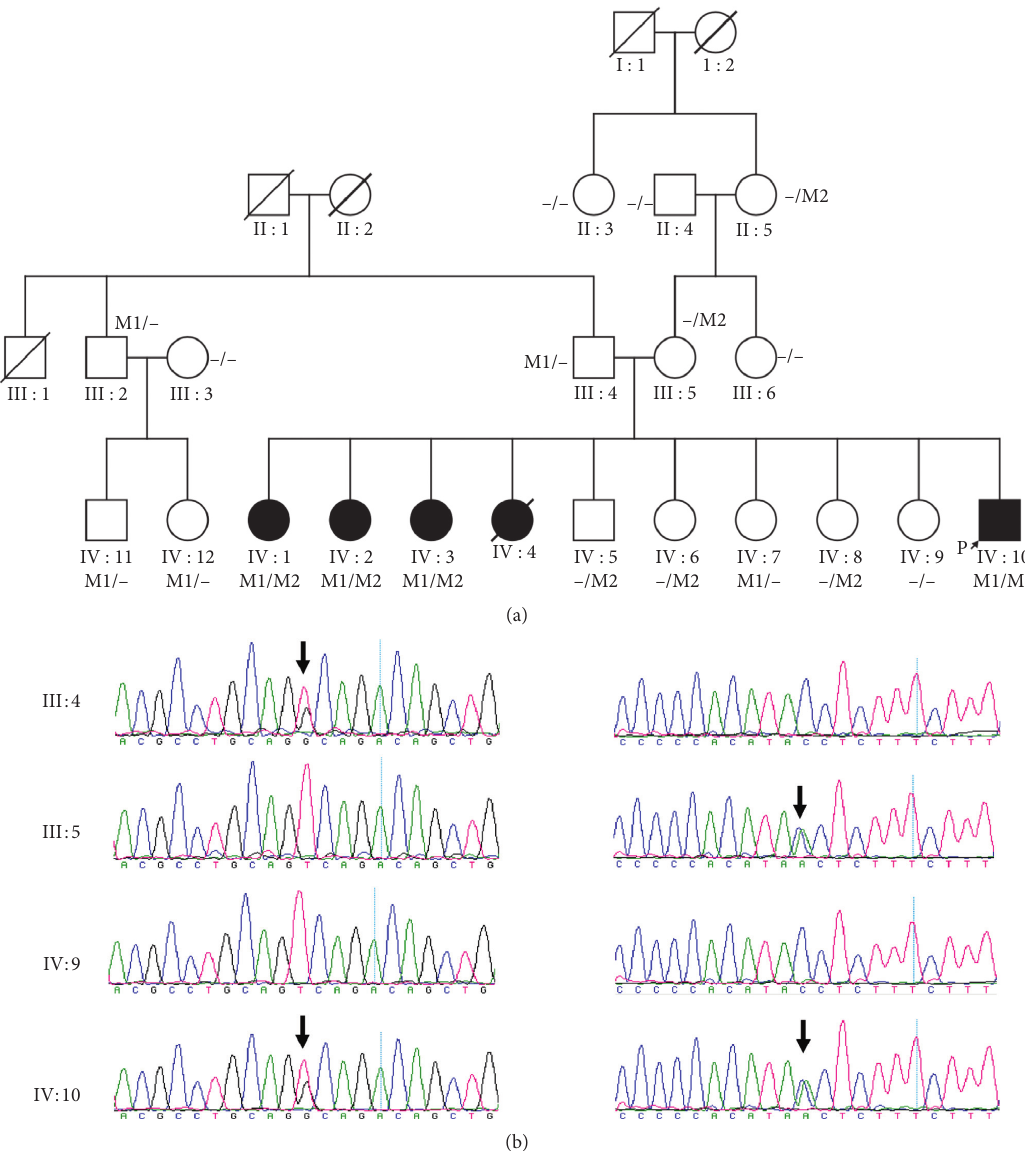
Figure 1: The pedigree and DNA sequencing of family (a) A. The pedigree of family A: M1 stands for variant c.235T > G (p.T79P) in the BBS2 gene, and M2 stands for variant c.534+1G > T in the BBS2 gene. (b) The Sanger sequencing of this family. The left column is the sequencing of variant c.235T > G, and the right column is the sequencing of variant c.534+1G > T. The arrows indicate where the variant